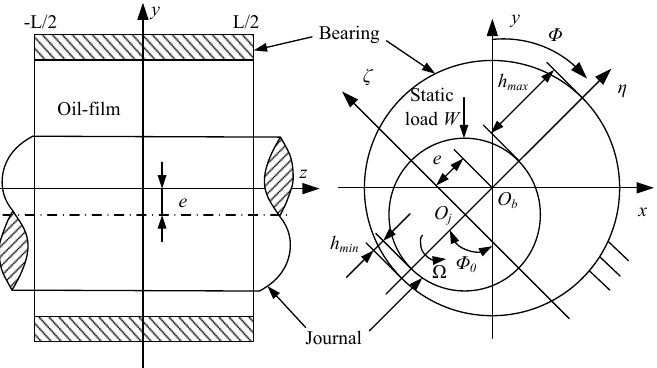
Figure 1. General HDB and associated